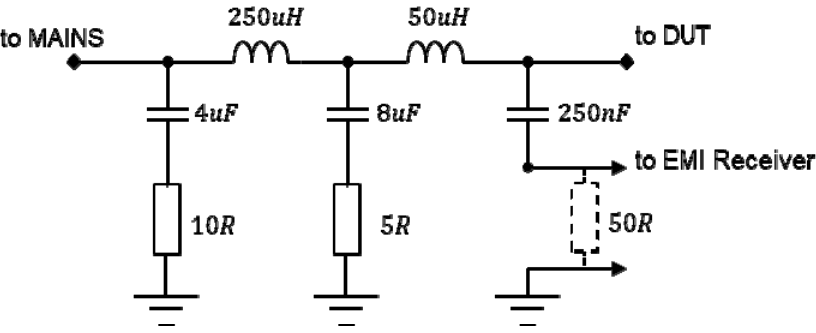
Figure 1. A CISPR-16-1-2 compatible one phase leg LISN circuit diagram